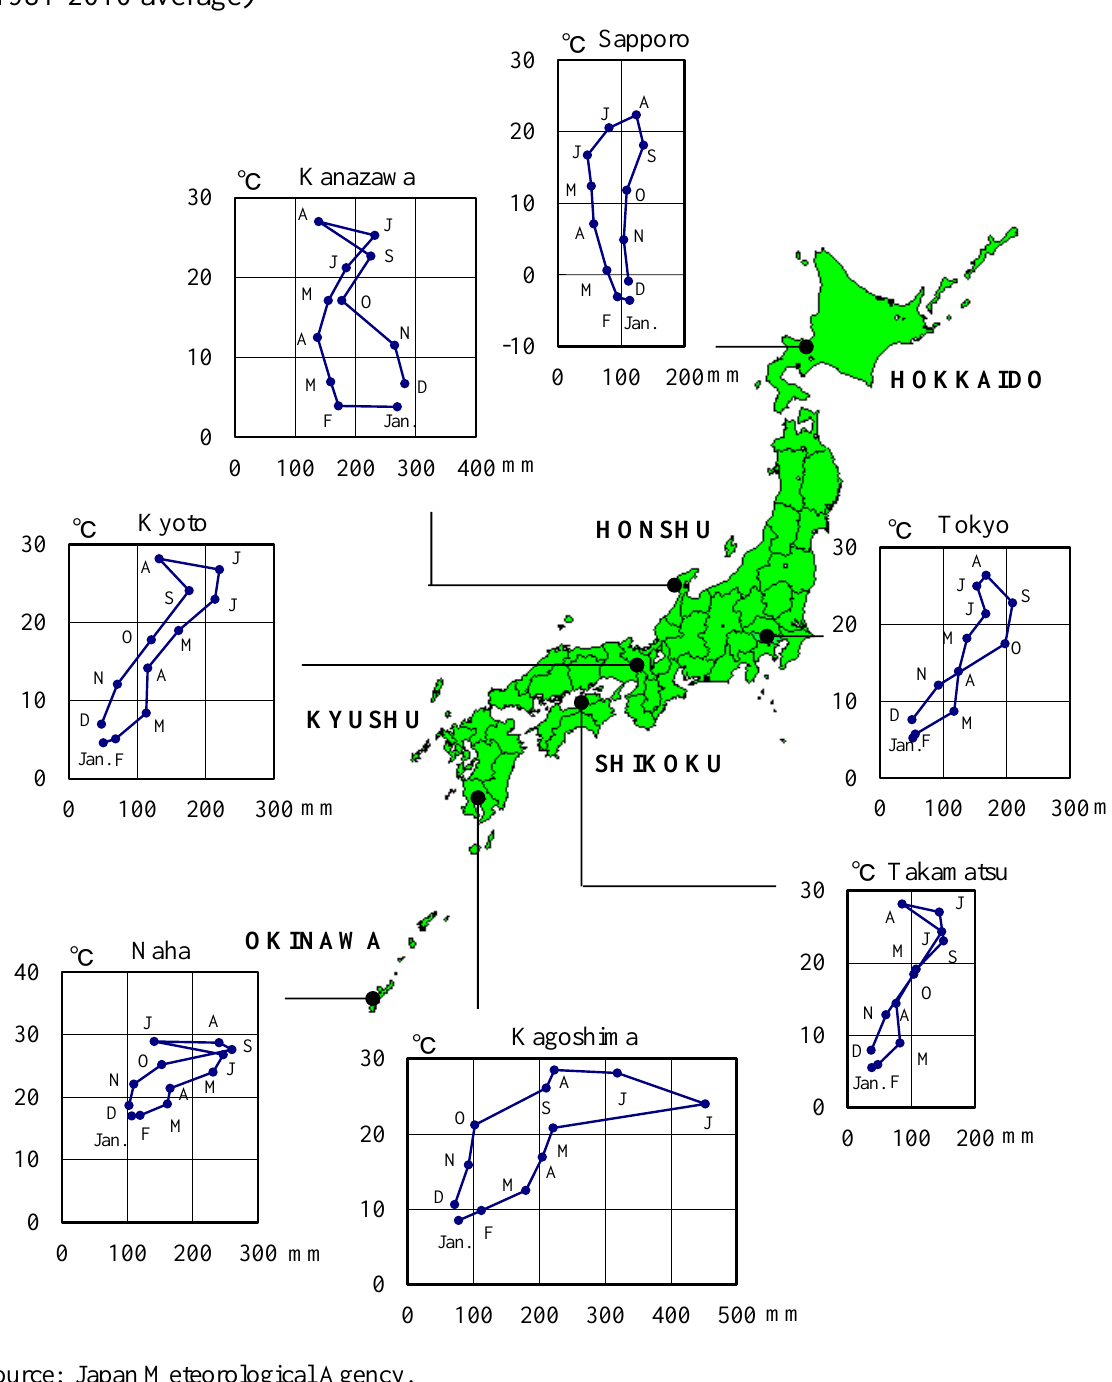
Temperature and Precipitation ( Normal value ) ( 1981-2010 average